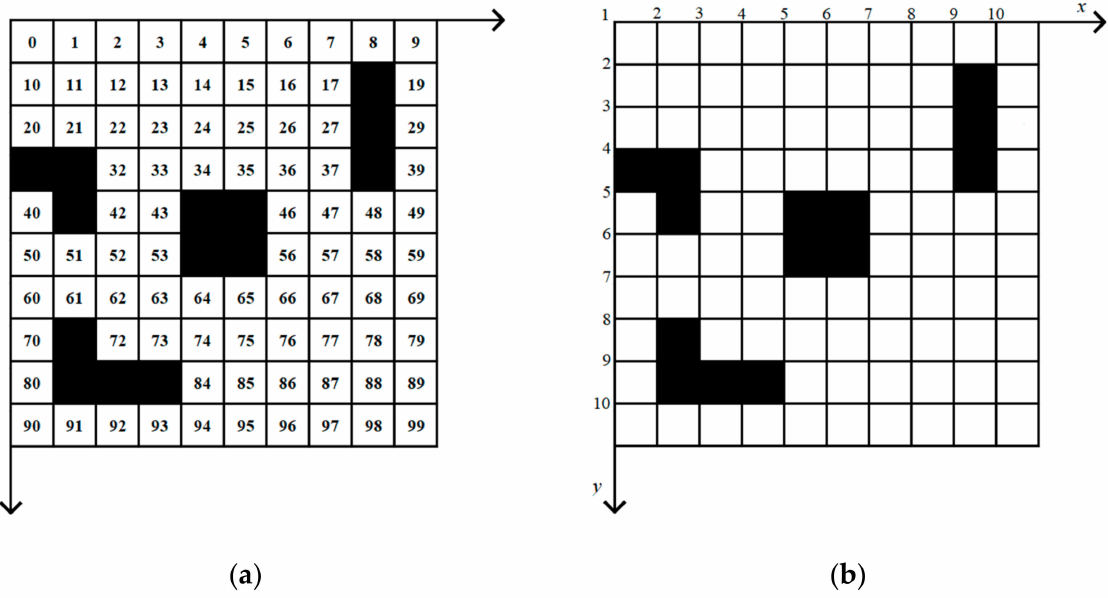
Figure 4. Example of a 10 × 10 grid map: ( a ) index to the grid; ( b ) coordinate of the